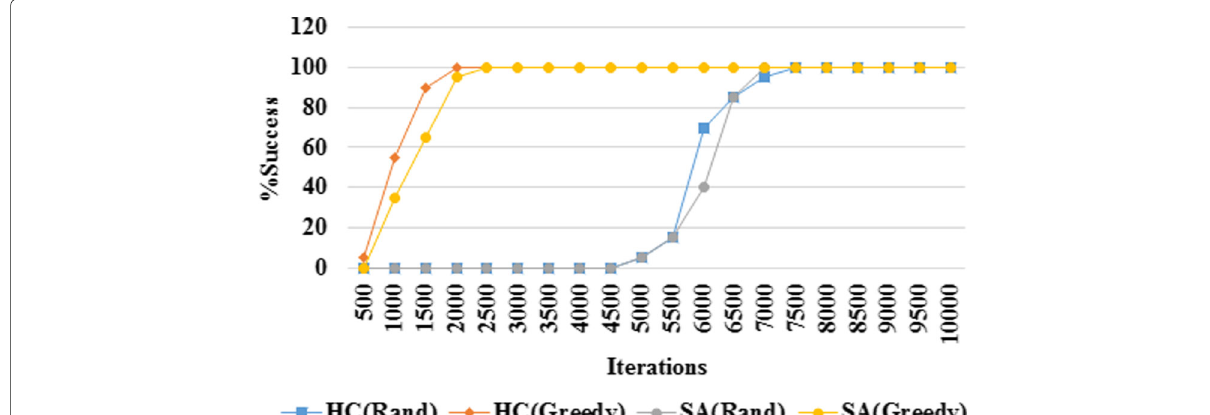
Fig. 9 Quality of Solution for a large instance